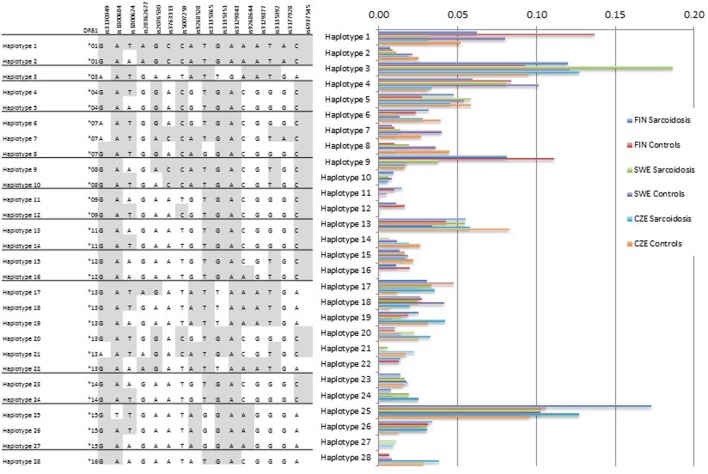
HLA-DRB1-SNP haplotype frequencies. HLA-DRB1 data were available for Finnish, Swedish, and Czech samples. Subjects with missing SNP genotype were excluded from the analysis. SNP order is the same as in the Table 2. The analysis shows population-specific differences in haplotype structures. Haplotype frequencies (2n) > 0.01 are presented.